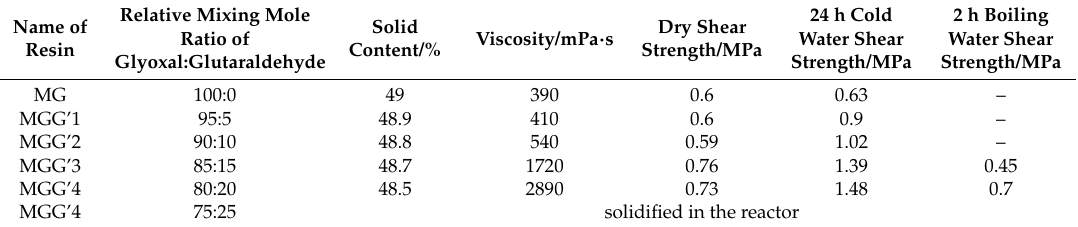
Table 2. Plywood results for melamine-glyoxal-glutaradehyde (MGG’) resins. MG resin of mole ratio M/G = 1:6, pH = 4.5, reacted at 60 ◦ C for 1 h. Three layers plywood were prepared and tested